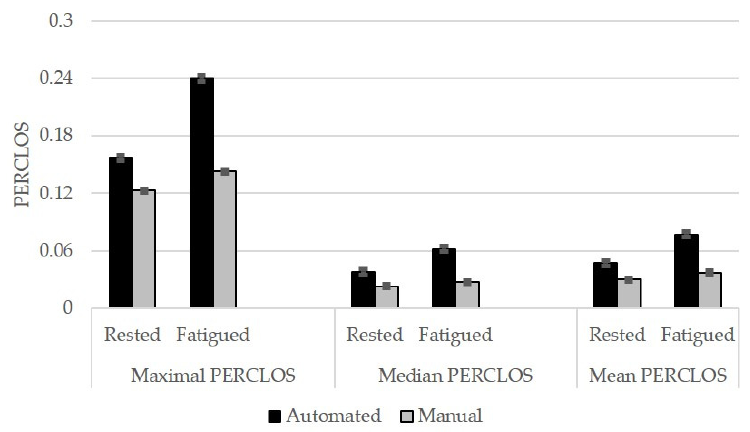
Figure 3. Effects of automation on drivers’ PERCLOS in rested and fatigued conditions. Error bars indicate